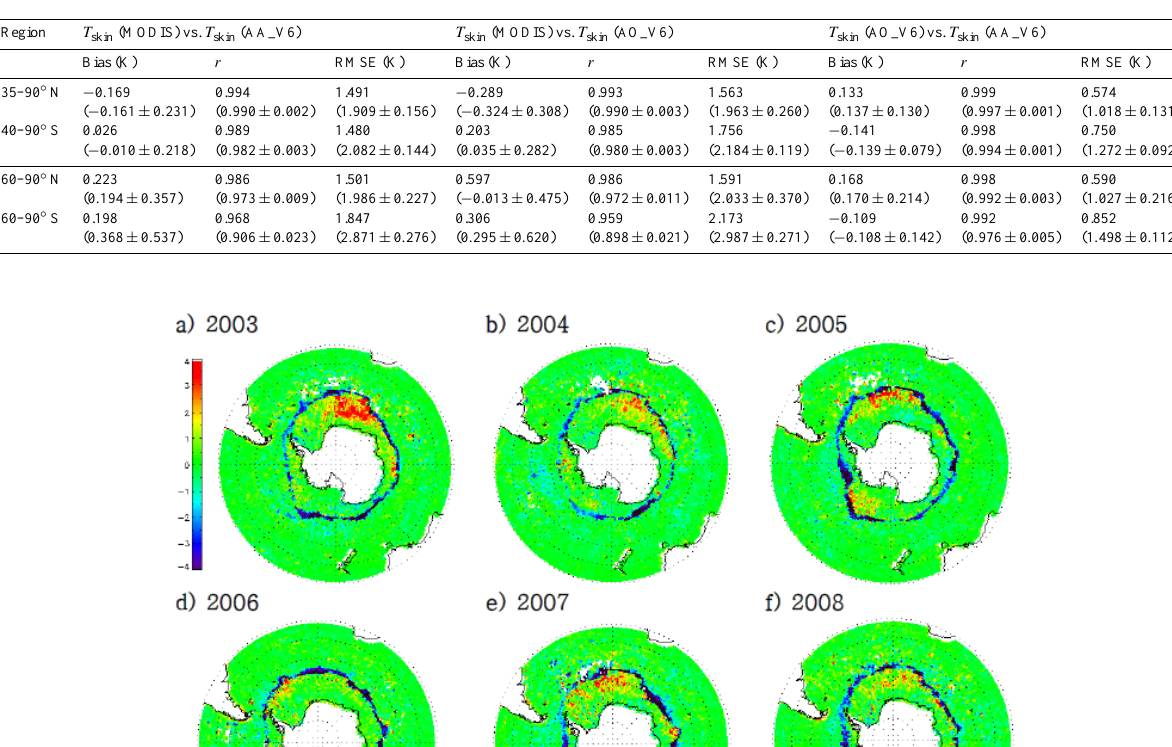
Table 2. Statistical comparisons of the climatological 9-day composite data during 2003–2014 over both hemispheres; T skin (MODIS) vs. T skin (AA_V6), T skin (MODIS) vs. T skin (AO_V6), and T skin (AO_V6) vs. T skin (AA_V6). The values in this table were calculated based on the 12-year composite mean values. The values in parentheses indicate the 12-year mean values and their standard deviations during 2003–2014. Bias: T skin (MODIS) minus T skin (AA_V6), T skin (MODIS) minus T skin (AO_V6), and T skin (AO_V6) minus T skin (AA_V6), r : correlation coefficient, RMSE: root mean square error.